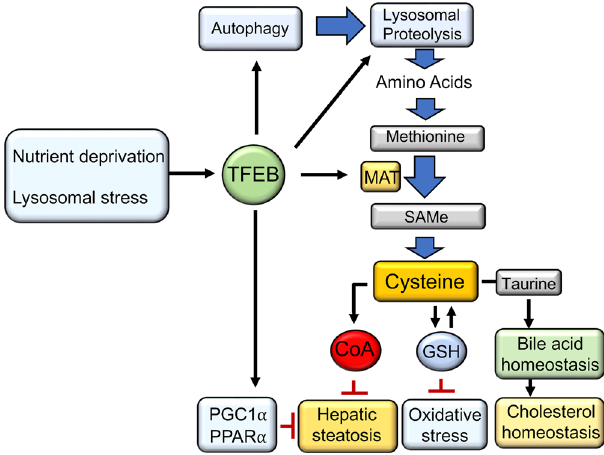
Fig. 8 | TFEB regulation of hepatic lipid metabolism and antioxidant defense. TFEB is a nutrient and stress-sensing transcriptional factor that plays an important role in regulating cellular metabolic homeostasis. This study shows that TFEB, via activation of the hepatic autophagy-lysosomal proteolysis and induction of sulfur aminoacid fl ux,increaseshepaticcysteineavailabilitythatdrivesdownstreamCoA, GSH and taurine synthesis. In addition, previous studies show thatTFEB, partly via PGC1 α induction, promotes PPAR α activation and fatty acid oxidation. Under NAFLD condition, incomplete fatty acid oxidation produces ROS to increase oxi- dative stress and mitochondrial dysfunction. Thisstudy shows thatTFEB mediates the synthesis of GSH that enhances hepatic antioxidant defense and redox home- ostasis. Previous study reports that TFEB induces bile acid synthesis to lower cholesterol. TFEB-mediated cysteine enrichment also drives the synthesis of taur- ine, which supports bile acid conjugationand homeostasis. In summary, this